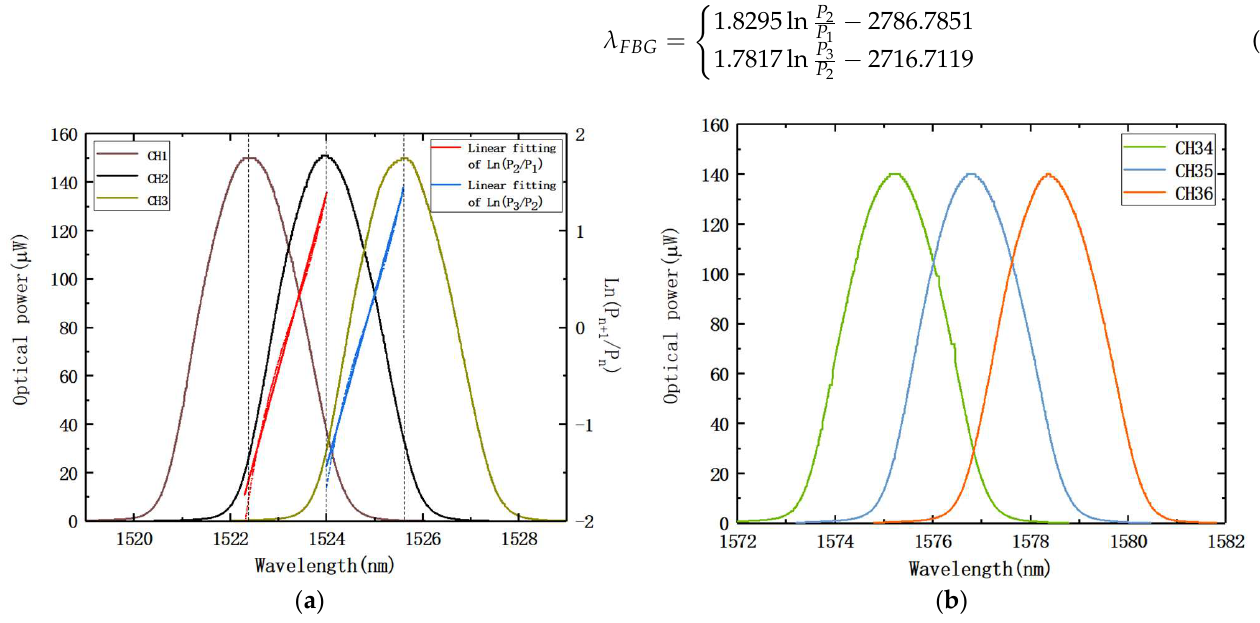
Figure 13. The interrogation results of the experiments employ ( a ) AWG channels 1, 2, and 3; ( b ) AWG channels 34, 35, and 36. Table 3. The central wavelengths corresponding to AWG channels 1, 2, 3, and 36.